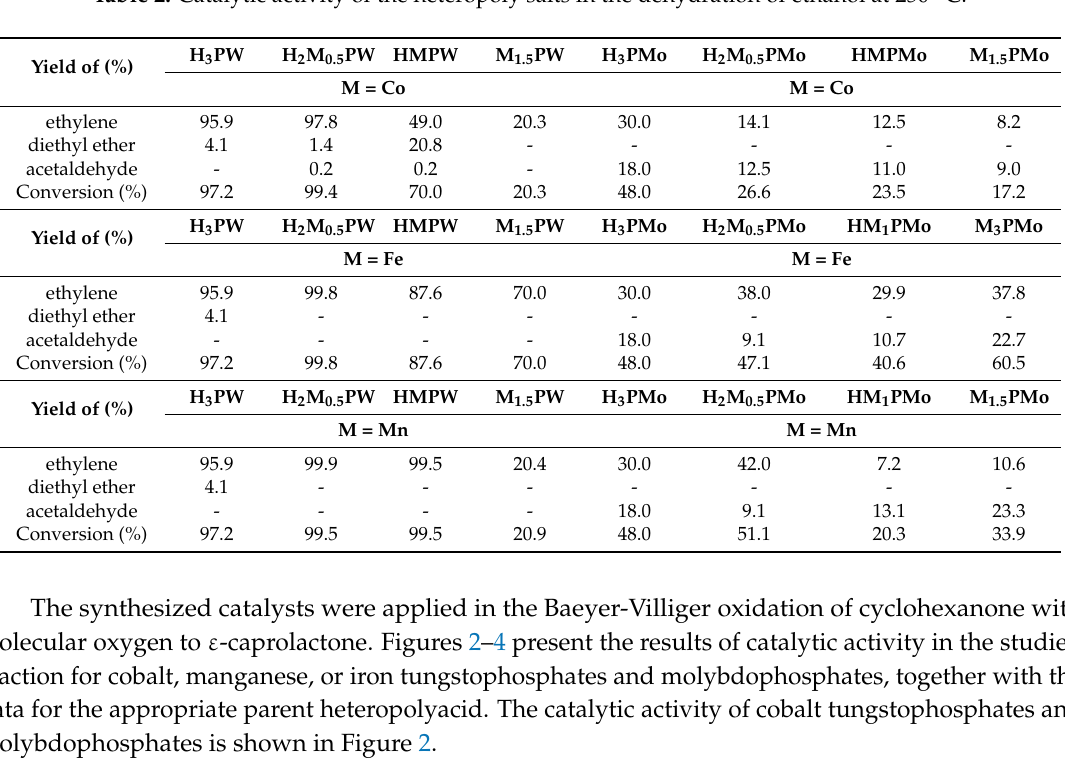
Table 2. Catalytic activity of the heteropoly salts in the dehydration of ethanol at 250 °C. H 3 PW Yield of (%) Yield of (%) diethyl ether